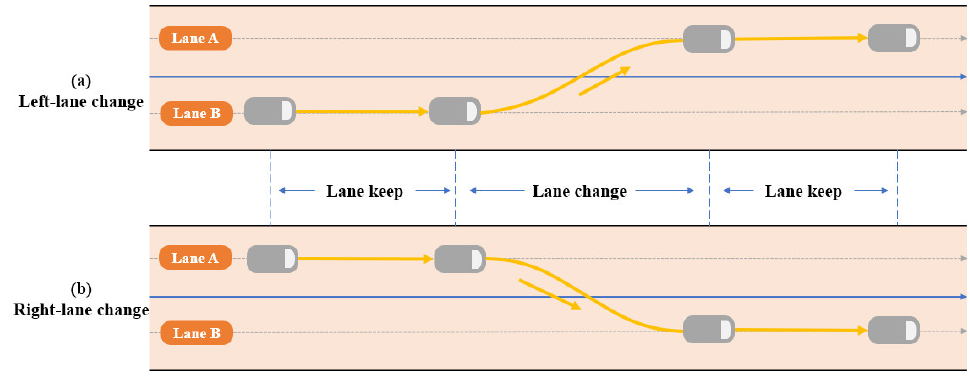
Figure 10. The direction of a lane change.